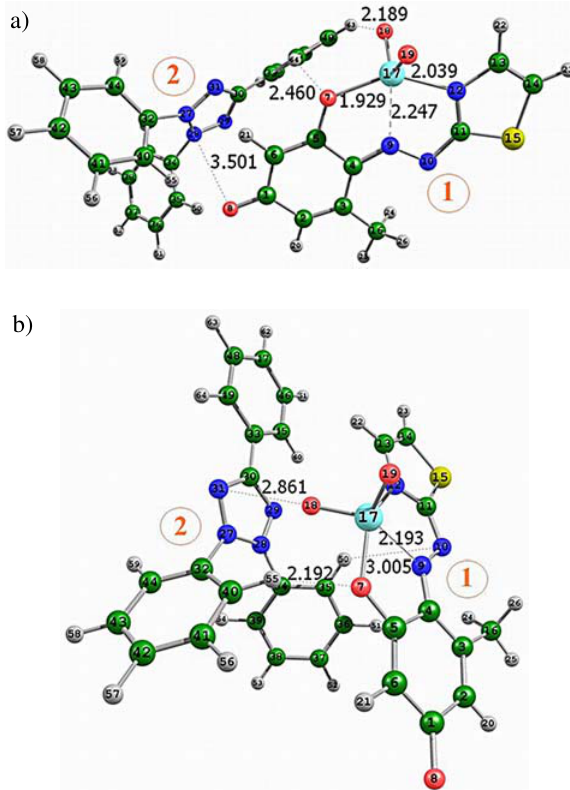
Figure 7. Optimized ground-state equilibrium geometries of the single complexes. a) S1 b) S2